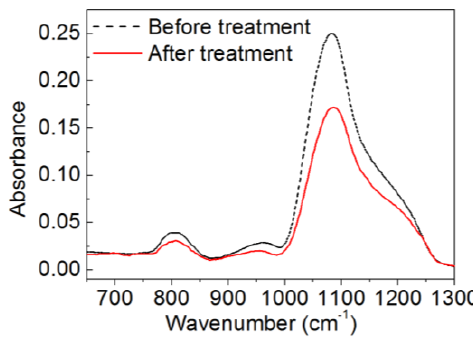
Figure 6. Fourier transform infrared (FTIR) absorption spectra of silica nanoparticles before and after treatment.